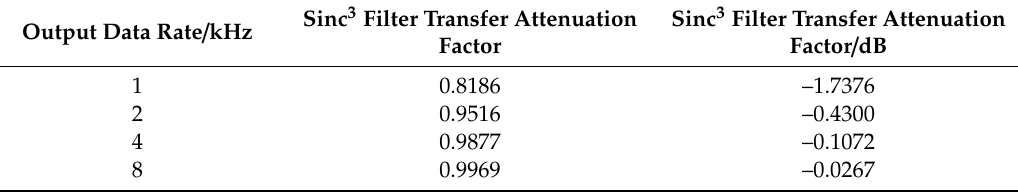
Table 10. Attenuation factors at 200 Hz by the sinc 3